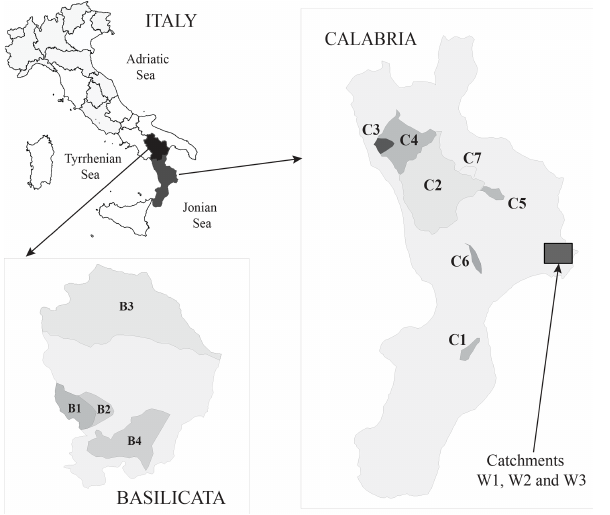
Figure 2. Location of the catchments investigated in this study. the annual datasets of sediment yield (see Table 1 and Fig. 2 for details).